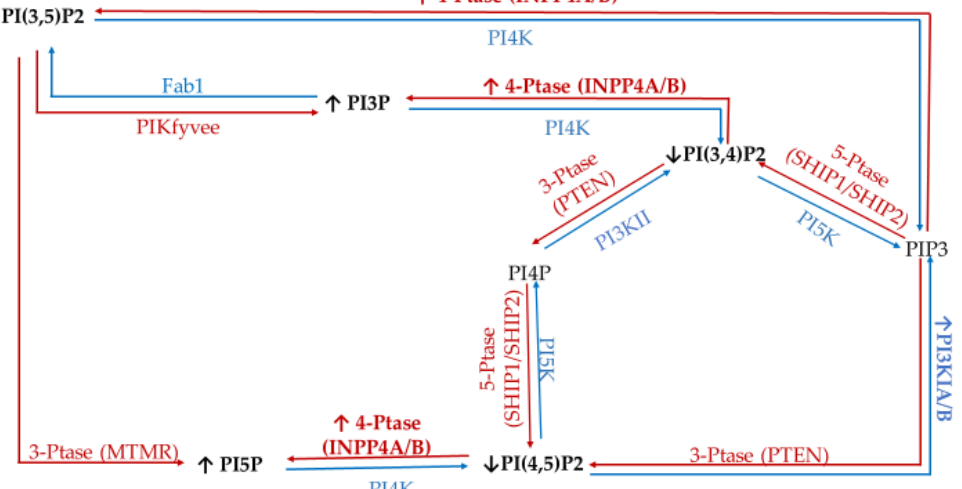
Figure 1. Estrogen receptor (ER+)/progesterone receptor (PR+) related expression of phosphatidylinositol (PI) kinases and phosphatases. Graphical representation of the hormone responsive breast cancer specific overexpression/increased activity (  ) and decreased expression/activity (  ) of the kinases (blue), phosphatases (red), as well as the hypothesized effects on the resulting lipidome.